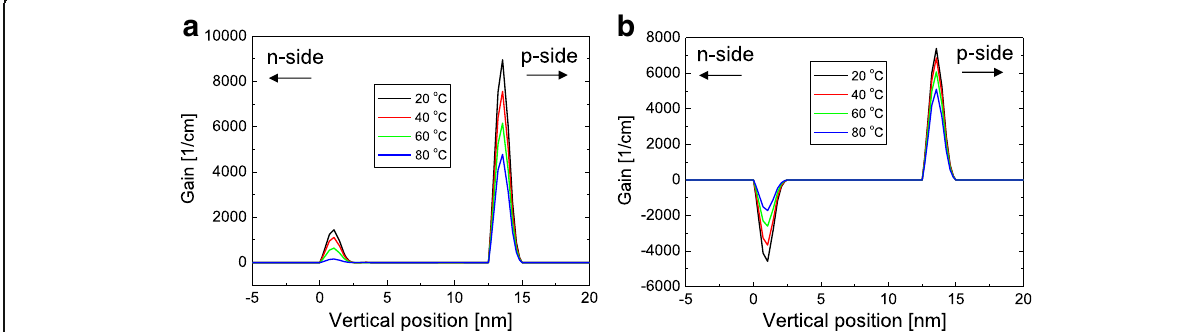
Fig. 6 Gain concentration distribution at 30 mA for temperatures of 20, 40, 60, and 80 °C when the n-type doping concentrations of the barrier are a 1 × 10 17 cm − 3 and b 2 × 10 18 cm − 3 . Here, the barrier thickness is fixed at 10 nm